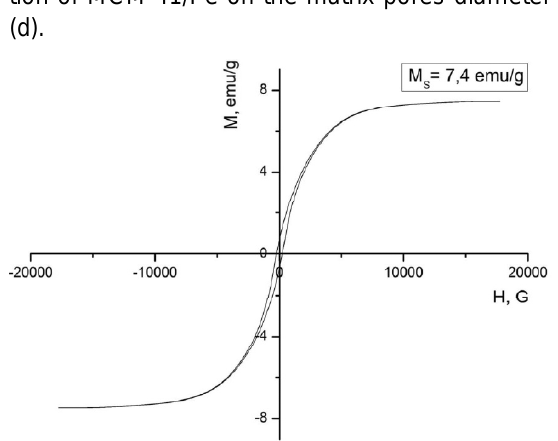
Fig. 4. Magnetization diagram for MCM-41 / Fe (sample No. 1).